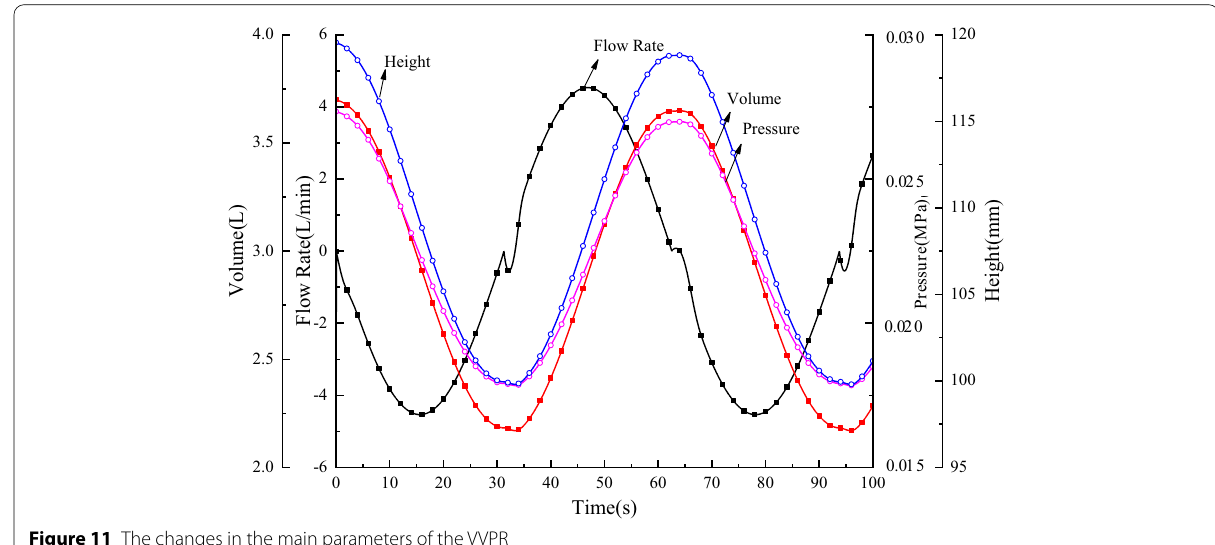
Figure 11 The changes in the main parameters of the VVPR